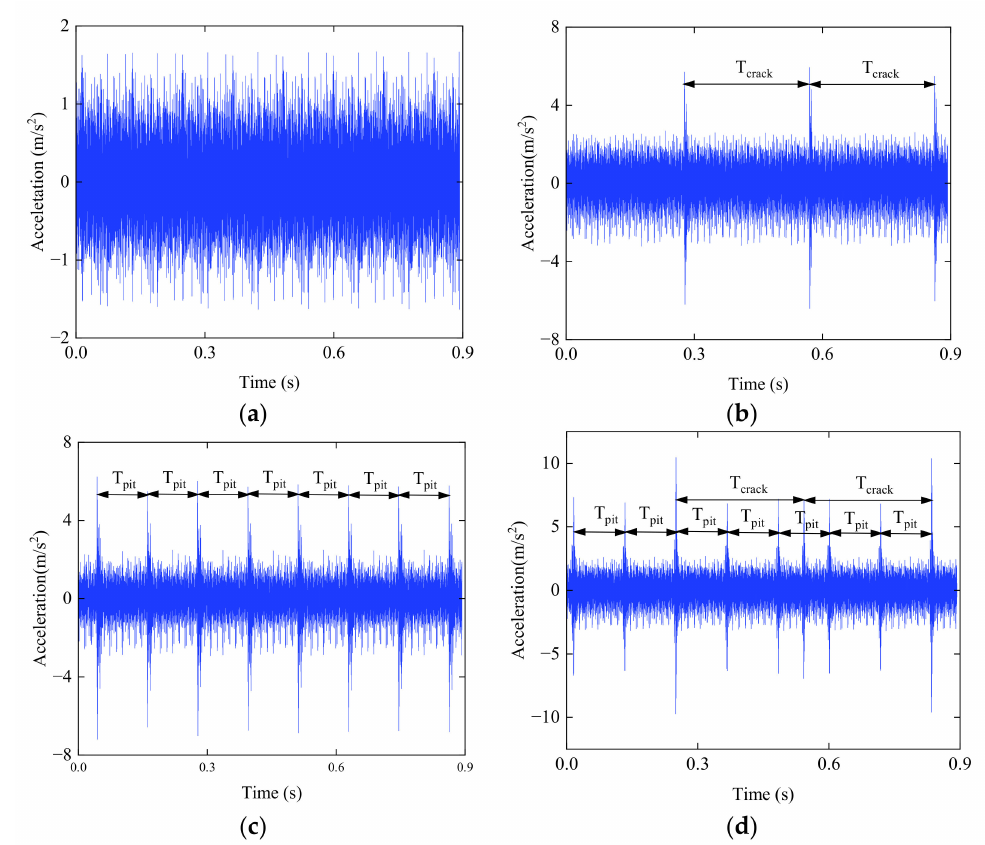
Figure 22. Simulated acceleration signals of gear systems with different faults: ( a ) Normal gear system; ( b ) Gear system with cracks; ( c ) Gear system with pitting.; ( d ) Gear system with cracks and